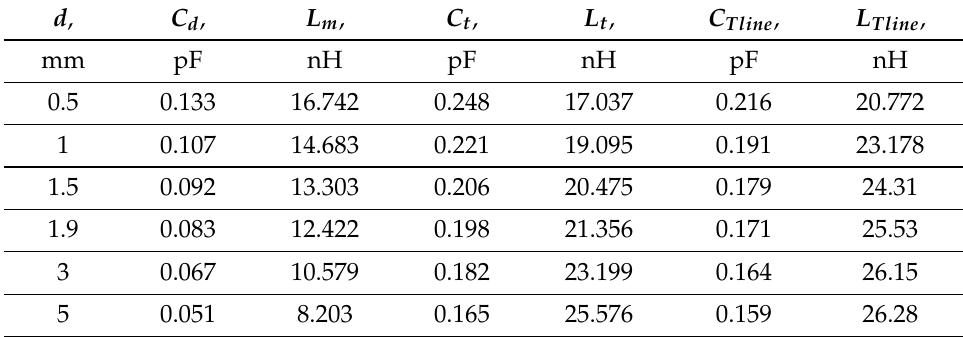
Table 3. Comparison of total distributed reactance.